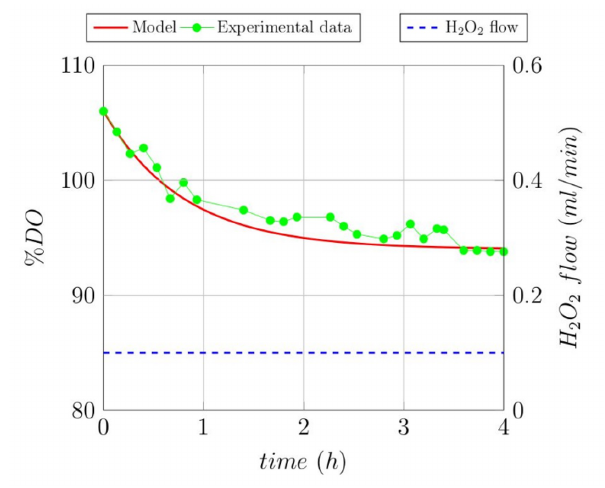
Figure 4. Degradation of melanoidin during the Open-Loop experiment.